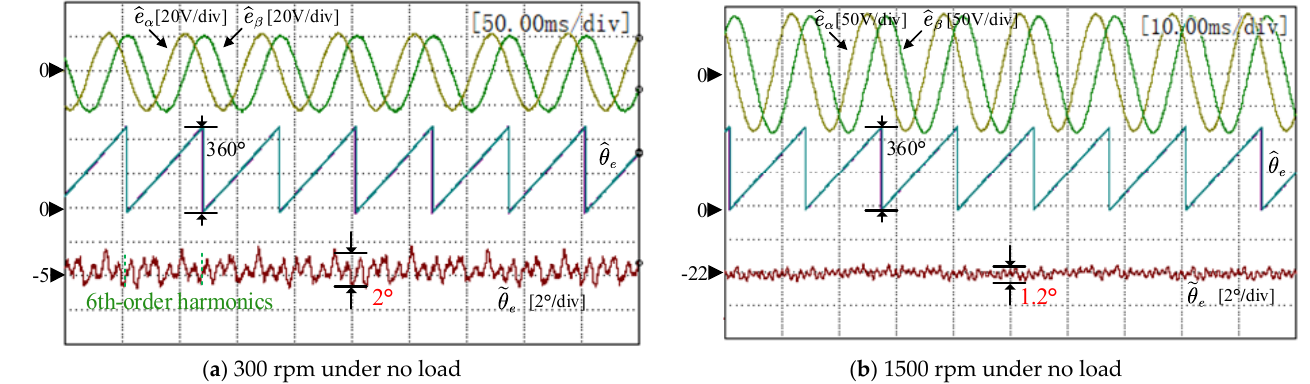
Figure 12. Experimental results of the estimated back-EMF, the estimated position, and the position error under no load (conventional QPLL).